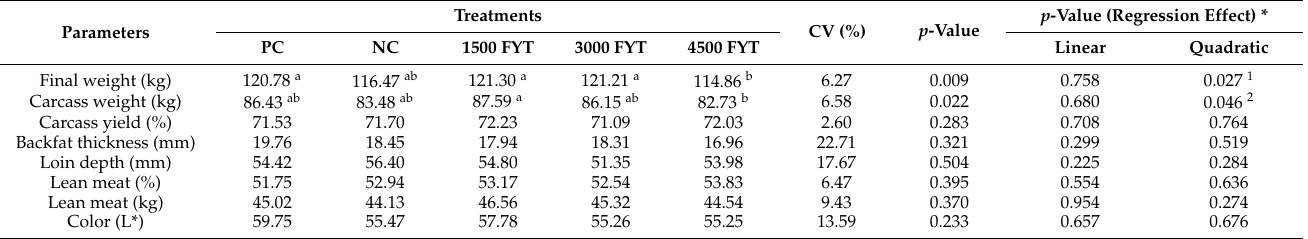
Table 3. Means of final weight, carcass weight, carcass yield, backfat thickness, loin depth, and lean meat percentage and yield according to the experimental